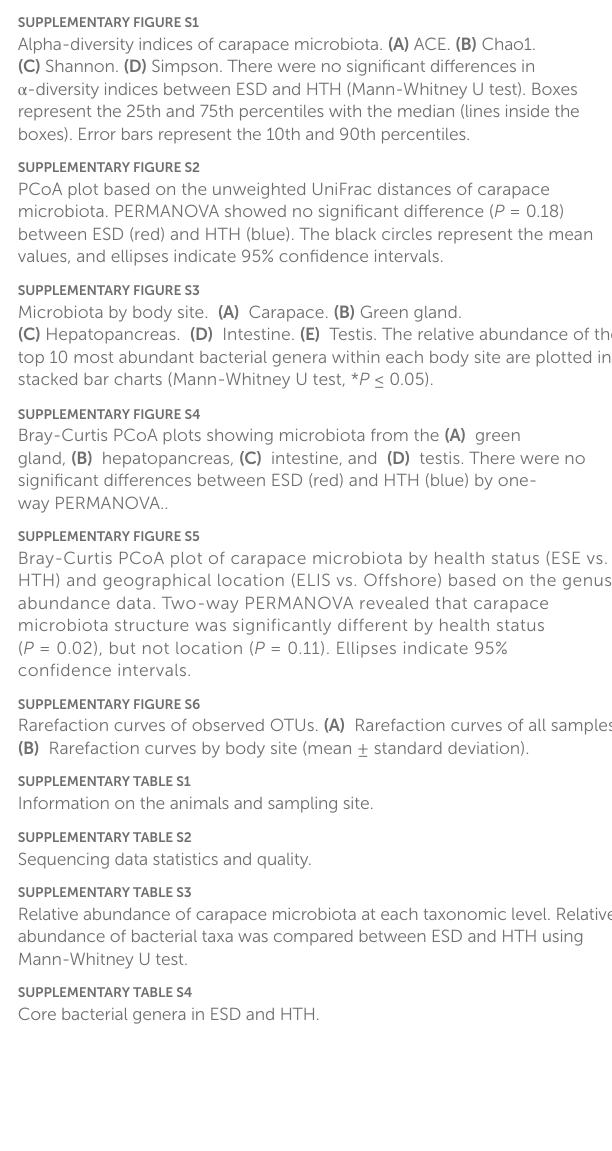
SUPPLEMENTARY TABLE S1 Information on the animals and sampling site. SUPPLEMENTARY TABLE S2 Sequencing data statistics and quality. SUPPLEMENTARY TABLE S3 Relative abundance of carapace microbiota at each taxonomic level. Relative abundance of bacterial taxa was compared between ESD and HTH using Mann-Whitney U test. SUPPLEMENTARY TABLE S4 Core bacterial genera in ESD and